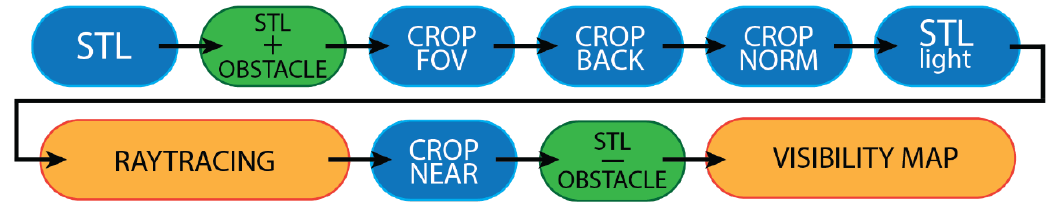
Figure 9. Visibility analysis framework: introduction of the element obstructing the scene (green